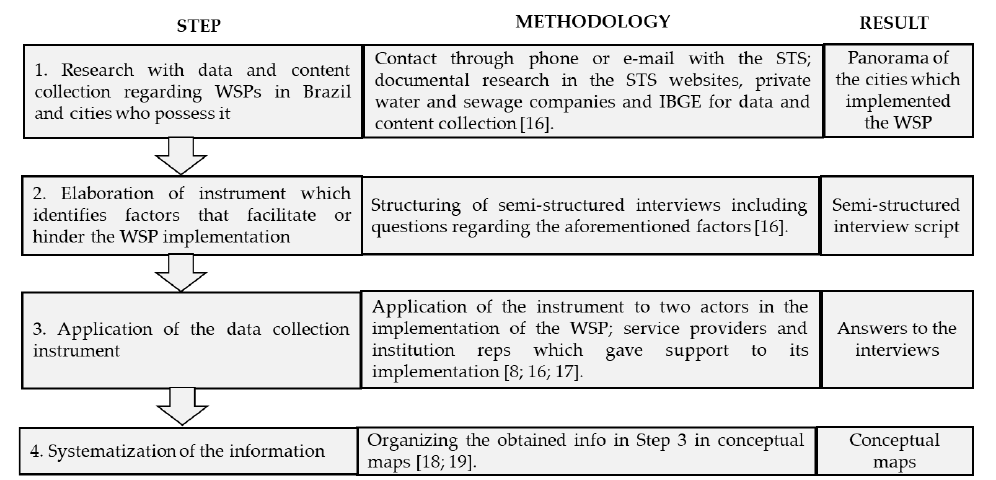
Figure 1. Objectives, methodology, and results of the steps for the execution of this work (drafted by the author).